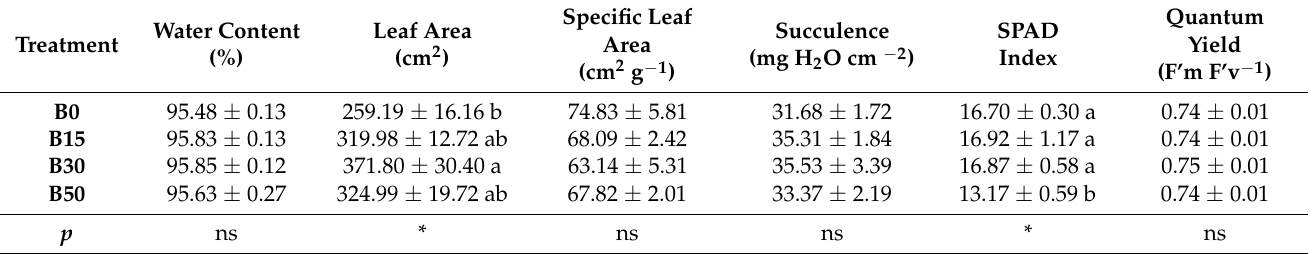
Table 6. Water and stress-indicating parameters in lettuce plants cultivated under different peat:bi- ochar substrates. Plants grown on different biochar:peat mixtures.